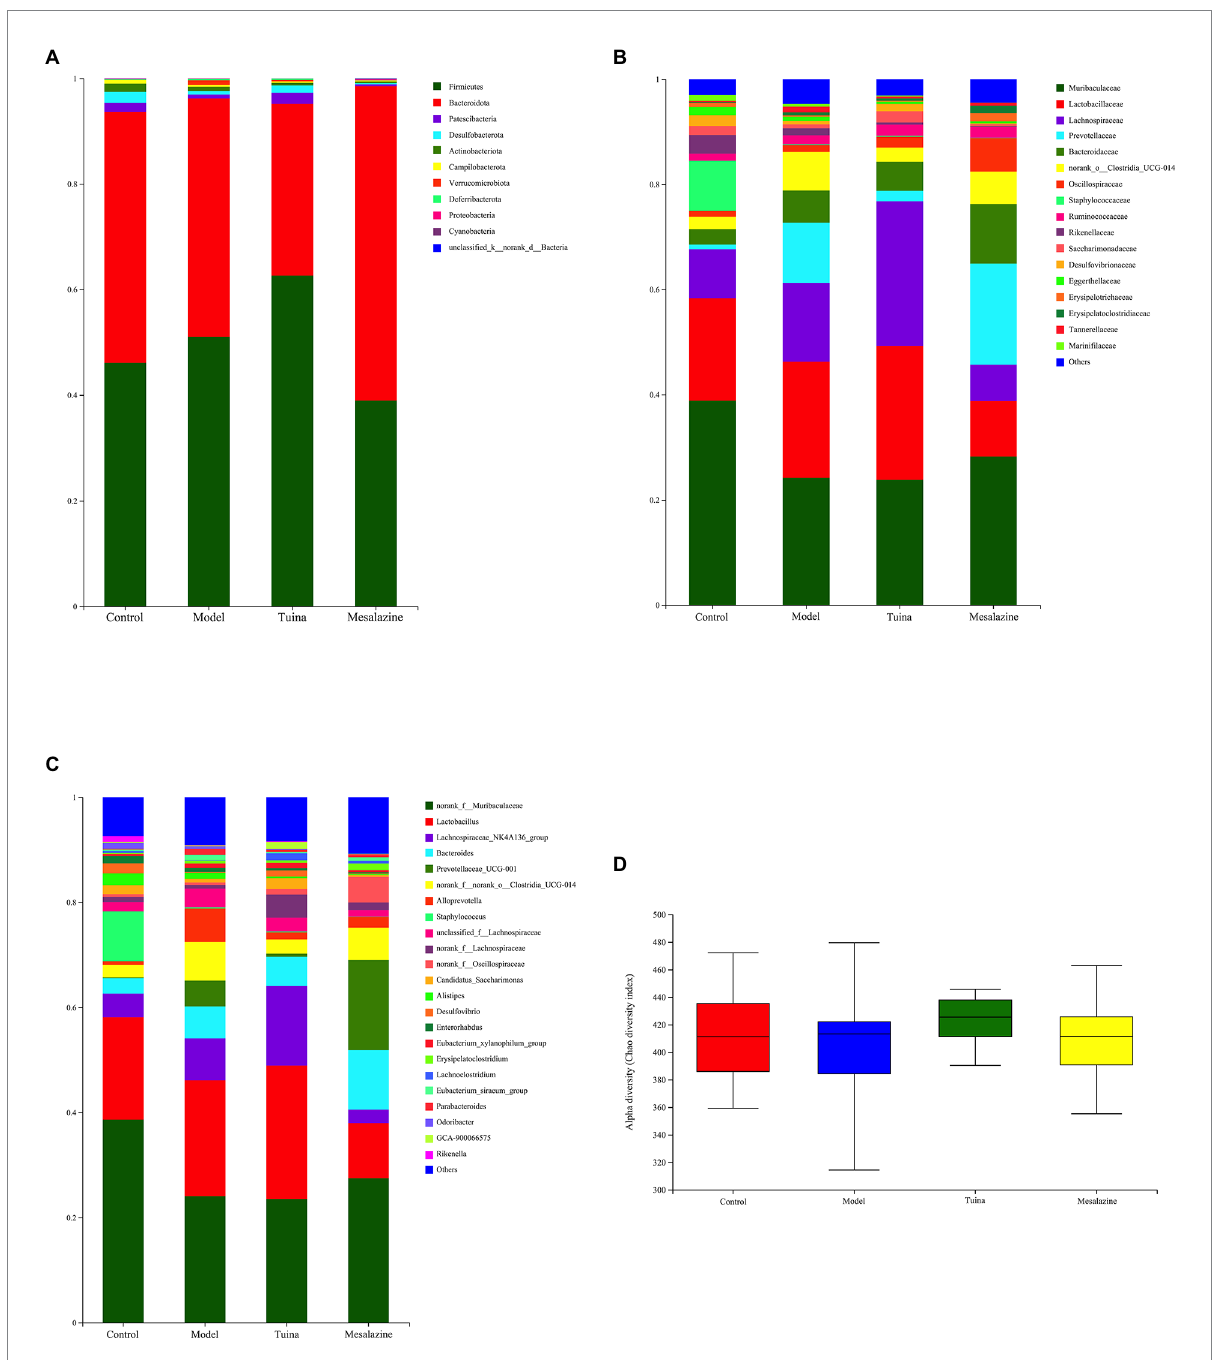
FIGURE 3 Analysis and comparison of dominant phylum, family, and genus in different groups. (A) At the phylum level, the horizontal coordinate represents the group and the vertical coordinate represents the percent of community abundance; (B) At the family level; (C) At the genus level; (D) The alpha diversity (Chao diversity